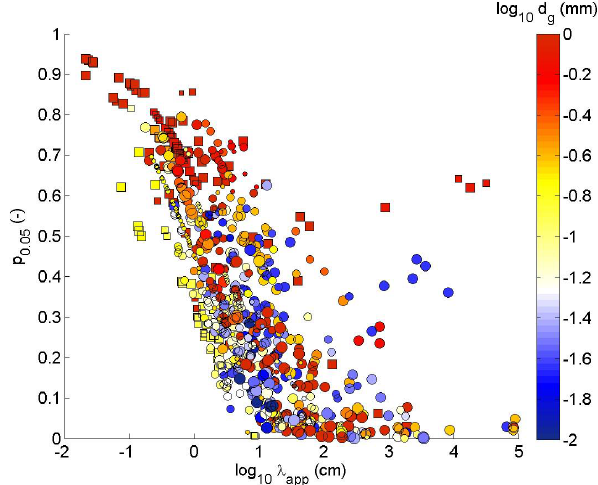
Fig. 8. Comparison of the apparent dispersivity, λ app , and normal- ized 5%-arrival time, p 0 . 05 , with the geometric mean grain diame- ter, d g , of the respective soil sample. The symbol size corresponds to the water fluxes, q , under which the respective experiment was conducted, small symbols indicating small water fluxes, large sym- bols denoting large water fluxes. The meaning of the symbol shape is explained in Fig.